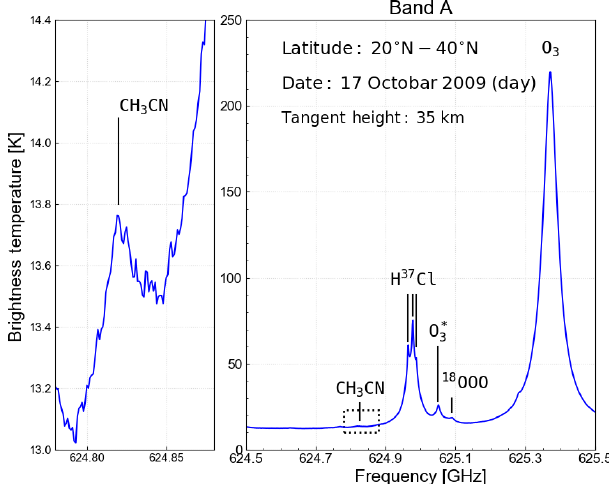
Figure 1. Example of a SMILES spectrum (L1b v008) of Band A. A total of 50 scans were accumulated at a tangent height of 35 ± 2 . 5km over the daytime on 17 October 2009.